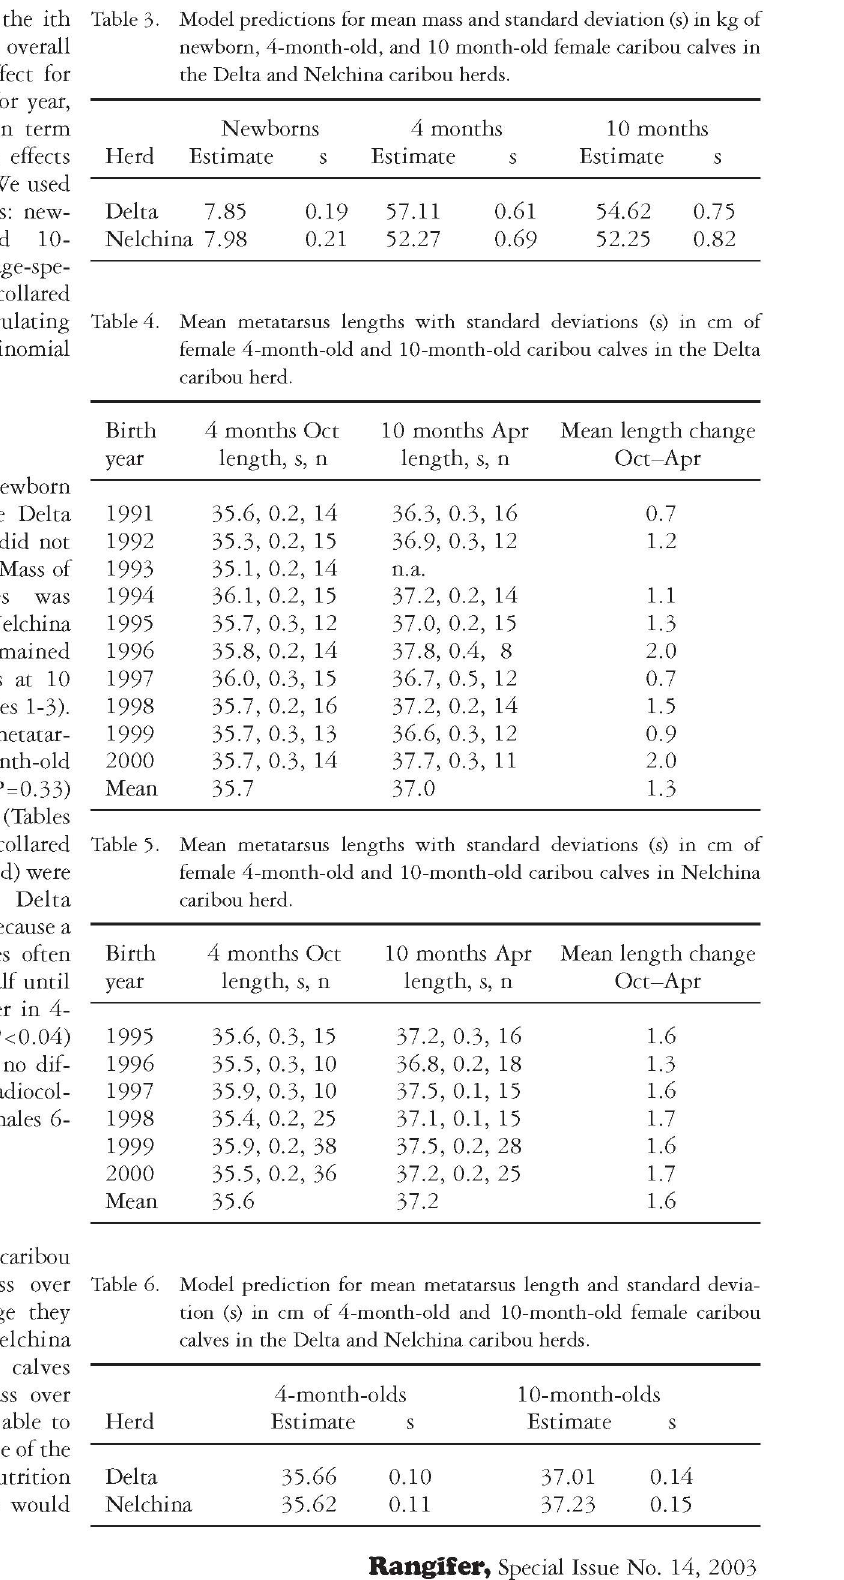
Table 3. Model predictions for mean mass and standard deviation (s) in kg of newborn, 4-month-old, and 10 month-old female caribou calves in the Delta and Nelchina caribou herds.